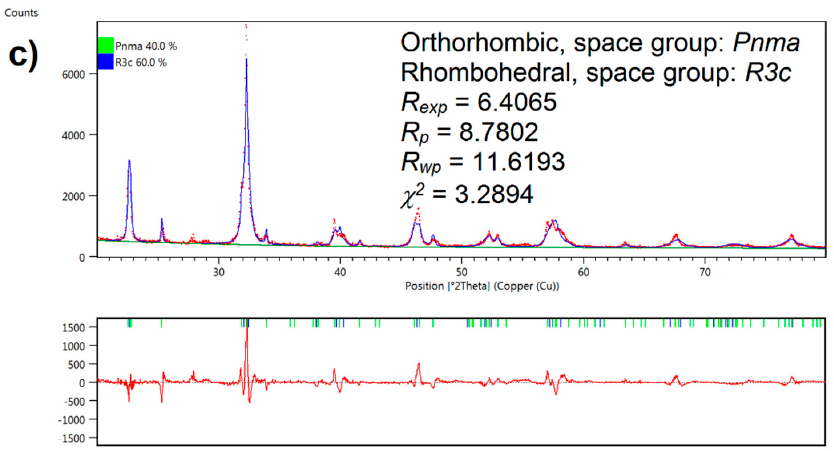
Figure 2. ( a ) X-ray diffraction (XRD) patterns of Bi 1 − x Eu x FeO 3 calcined powders, ( b , c ) Rietveld refined patterns for x = 0.05 and x = 0.20.